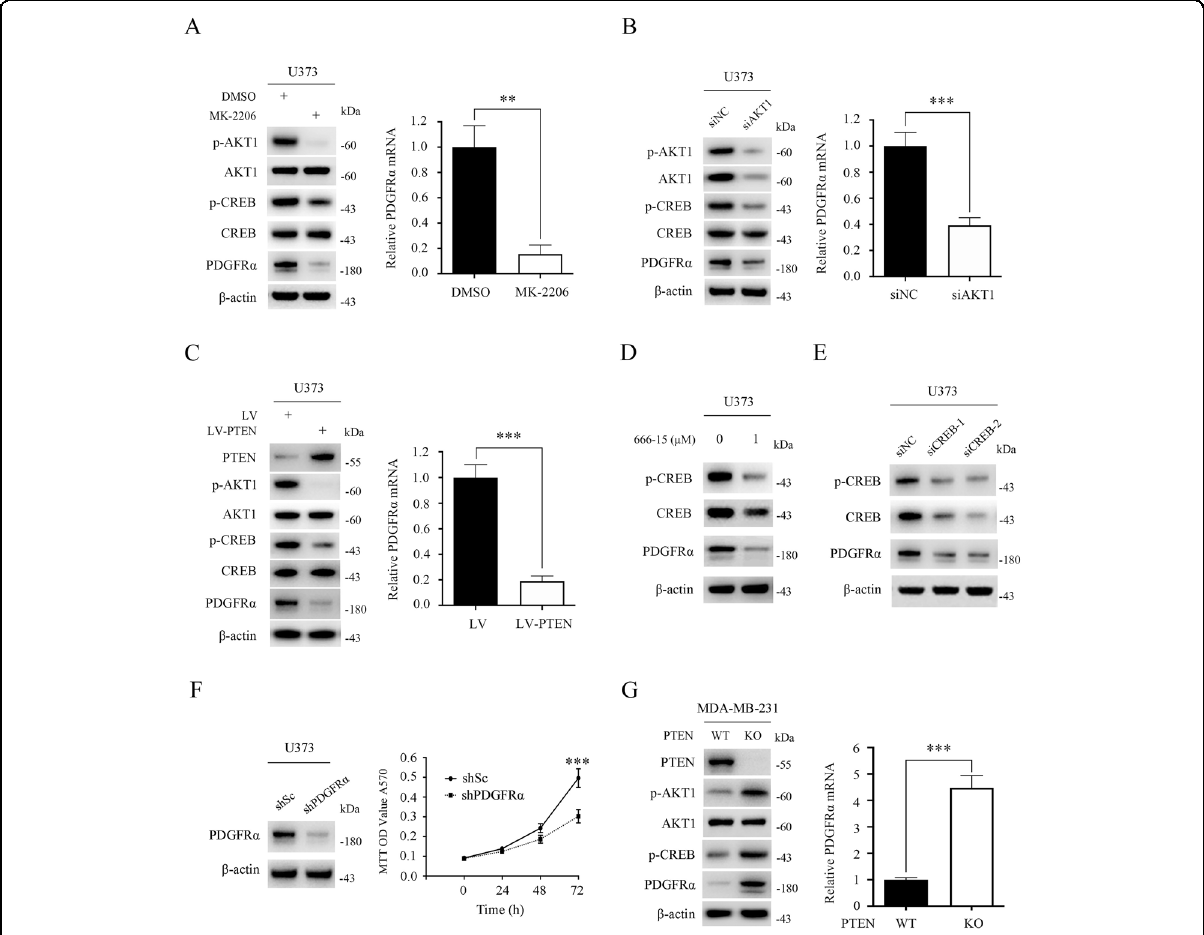
Fig. 5 PTEN-AKT1-CREB-PDGFR α signaling pathway exists in human cancer cells. A U373 cells were treated with MK-2206 (5 μ M) for 24h. B U373 cells were transfected with siNC or siRNA against AKT1 (human siAKT1) for 48h. C U373 cells were transduced with LV-PTEN or LV lentiviruses. A – C Cell lysates were subjected to immunoblotting (left panels), and qRT-PCR was performed to examine the expression of PDGFR α (right panels). D U373 cells were treated with 1 μ M 666-15 for 24h. E U373 cells were transfected with siNC or two independent siRNAs against CREB (human siCREB-1 and siCREB-2) for 48h, respectively. D , E Cell lysates were subjected to immunoblotting. F U373 cells were stably expressing shRNAs targeting PDGFR α (shPDGFR α ) or a control shRNA (shSc). Cell lysates were analyzed for PDGFR α expression by western blot (left panel). Proliferation of the indicated cells was examined using an MTT assay (right panel). G Pten wild-type (WT) or knockout (KO) MDA-MB-231 cells were subjected to western blot (left panel) and qRT-PCR (right panel) analyses. Error bars indicate mean ± SD of triplicate samples. ** P <0.01; *** P